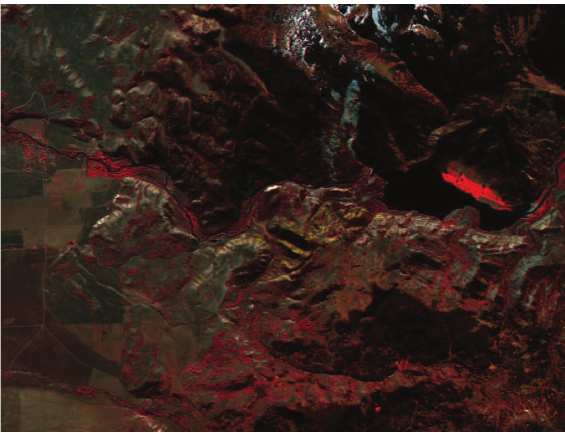
Figure 6. A band in false colors of the original raw Yellowstone scene 0 of the Aviris 2006 data